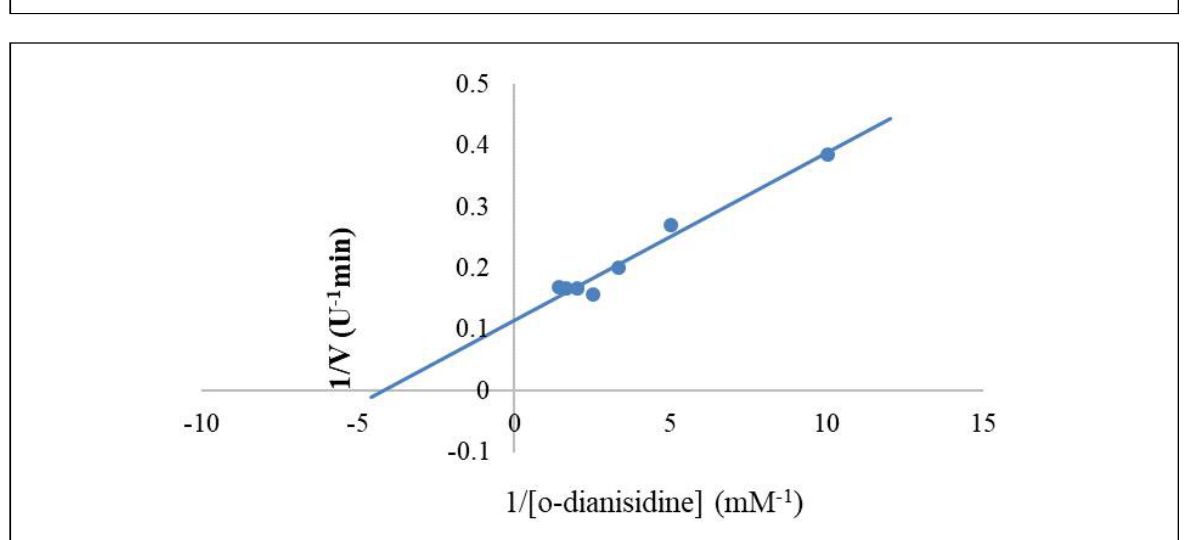
Figure 6: Lineweaver-Burk plot for peroxidase activity with graded concentrations of o-dianisidine (fraction A) (2010) reported that peroxidase from Raphanus sativus had K –0.036 mM for guaiacol and 0.0084 mM for m hydrogen peroxide, with V - 3512.23 U/min and 38728.17 U/min respectively. By applying max